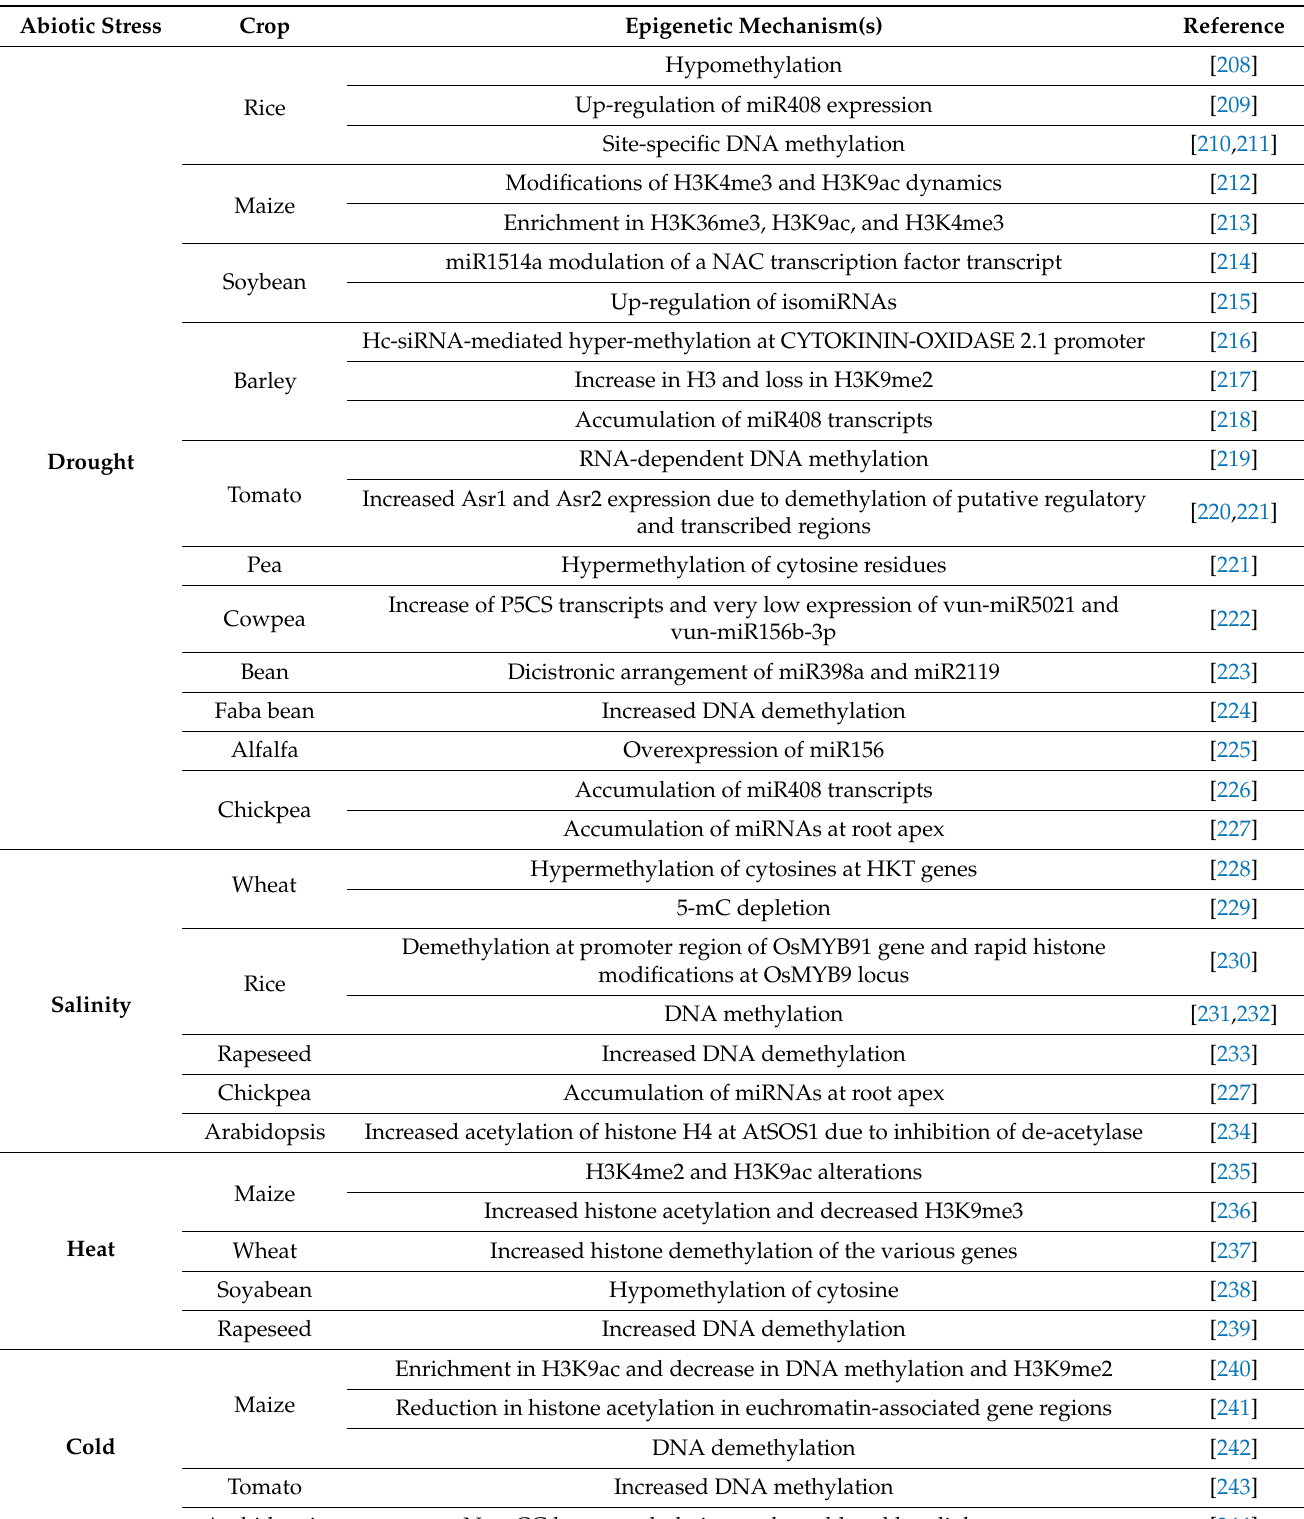
Table 2. Known epigenetic mechanisms involved in different abiotic stresses in